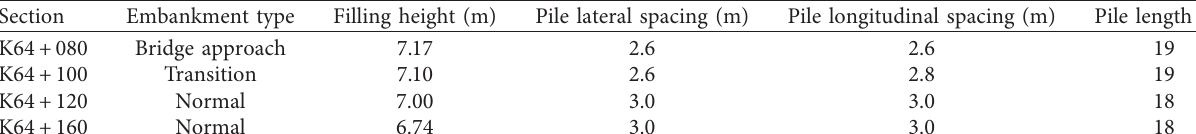
Table 3: Design parameters of the embankment and prestressed pipe pile.